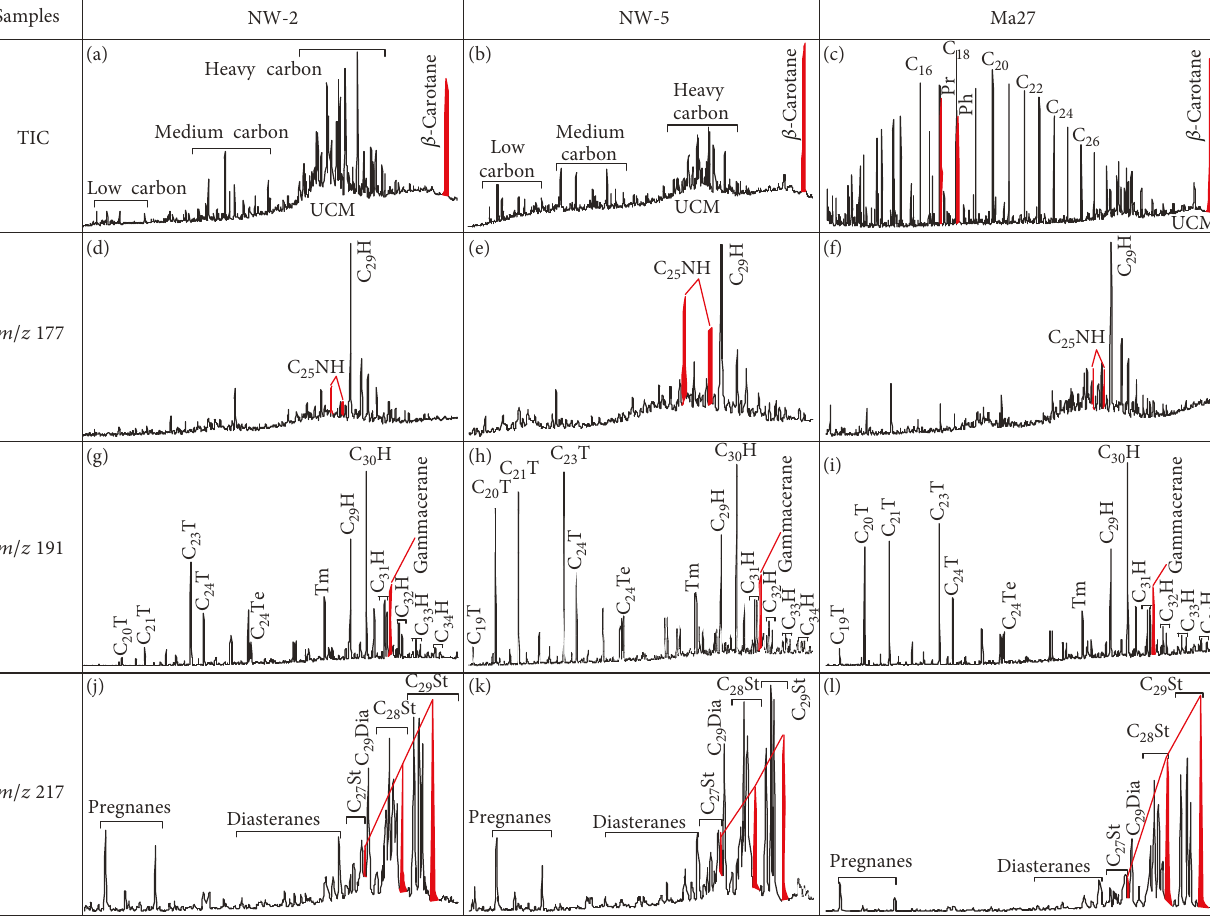
Figure 4: Selected molecular geochemical chromatograms of oil-seep and crude-oil samples from the northwestern Junggar Basin. TIC: total ion current mass chromatogram; UCM: unresolved complex mixture; T: tricyclic terpane; Te: tetracyclic terpane; NH: nor-hopane; H: hopane; Dia: diasteranes; St: